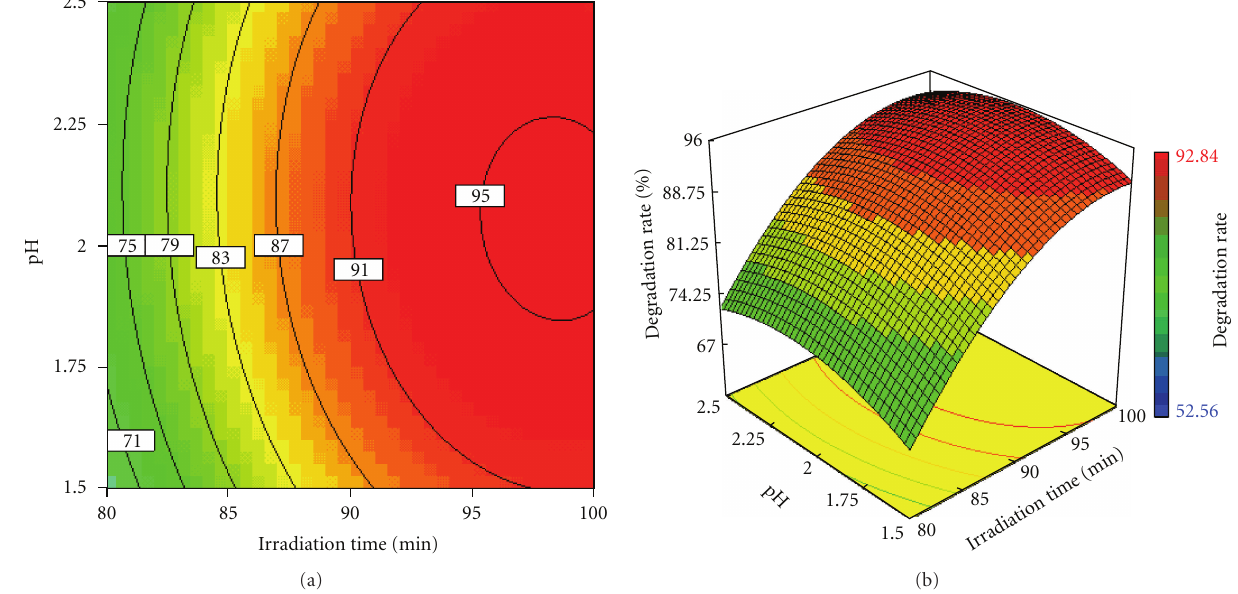
Figure 5: The response surface plot and the corresponding contour plot showing the e ff ects of irradiation time and pH on naphthalene degradation rate.